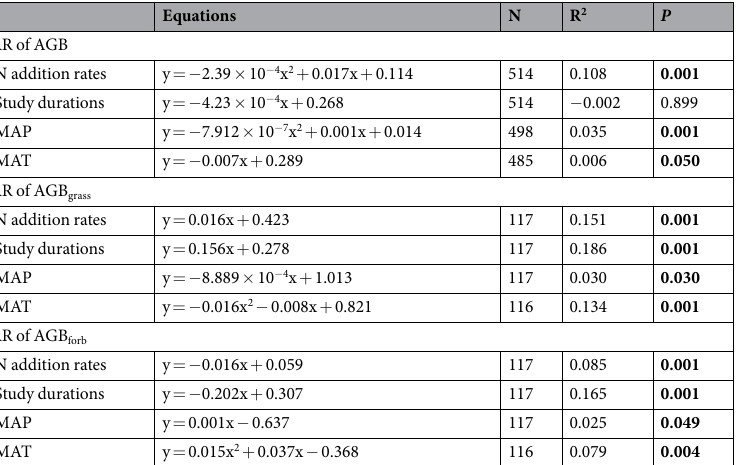
Table 1. The relationships between the response ratios (RR) of the aboveground biomass (AGB), the AGB of grasses (AGB grass ), the AGB of forbs (AGB forb ) and the N addition rates, study durations, mean annual precipitation (MAP), and mean annual temperature (MAT) under nitrogen (N) addition based on a regression analysis of global grasslands. Bold values indicate the significant portion of the variation among effect sizes that can be explained by an independent variable when p <